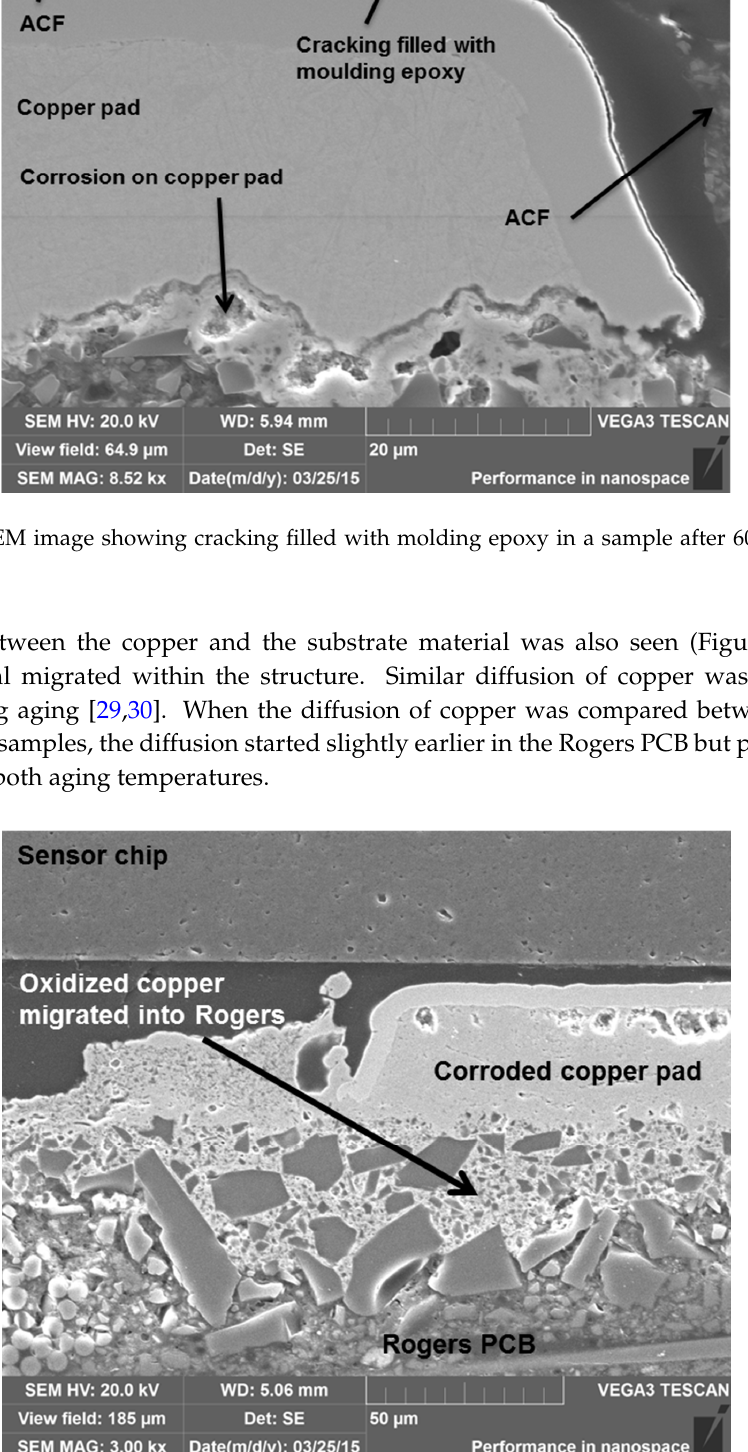
Figure 13. SEM migrograph showing the interface between Rogers and copper pad, indicating that the oxidized copper migrated into the Rogers material in a sample after 500 h of aging at 240 °C.